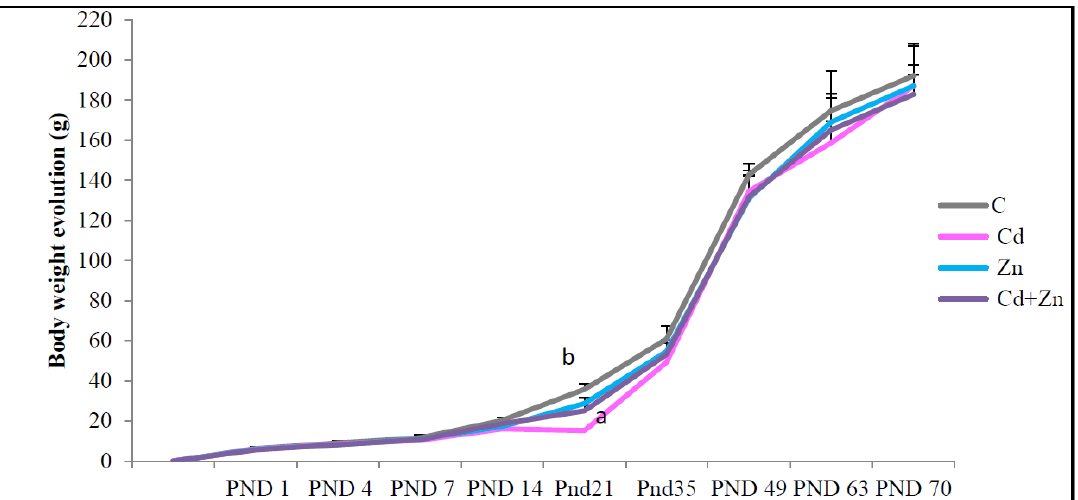
Figure 1. Body weight evolution of rat pups from control females and pups from females exposed to cadmium (50 mg/L Cd as CdCl2) and/or zinc (60 mg/L Zn as ZnCl2) during gestation and lactation. Values are expressed as mean ± SEM from 12 to 18 animals from each group (2–3 male per litter was measured). a ( p < 0.05): significant difference compared to the control group (C); b ( p < 0.05): significant difference compared to the Cd group (Cd).